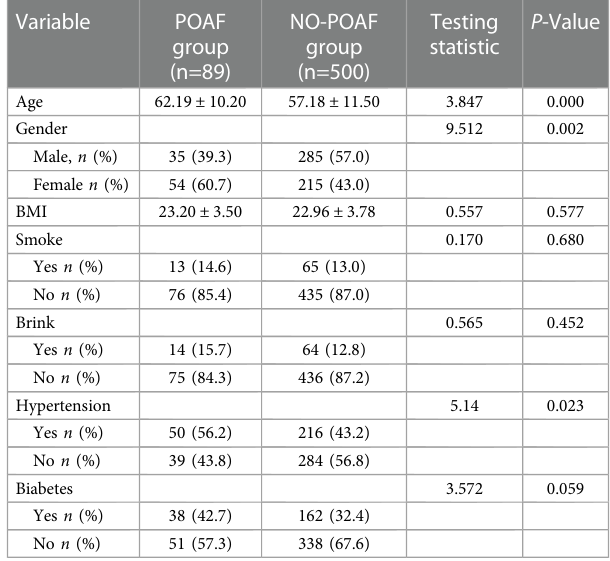
TABLE 1 Baseline patients